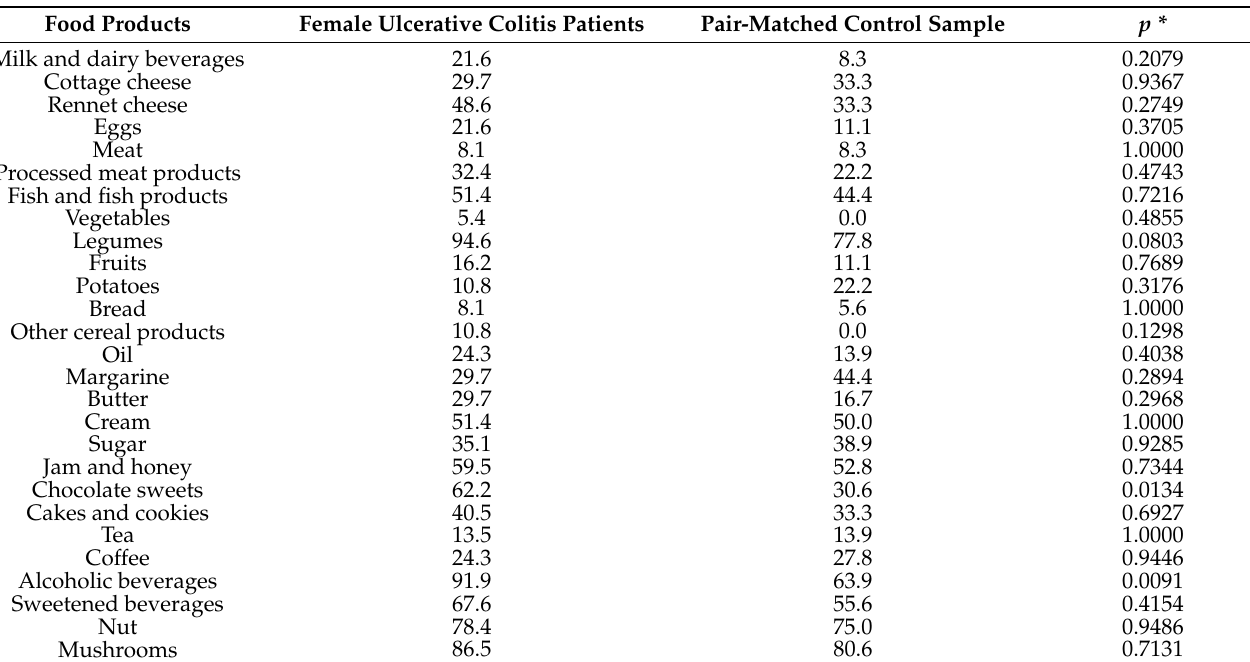
Table 9. The proportion of individuals declaring the exclusion of specific food products from their diet in the studied Polish female ulcerative colitis individuals, in comparison with a pair-matched control sample. Food Products